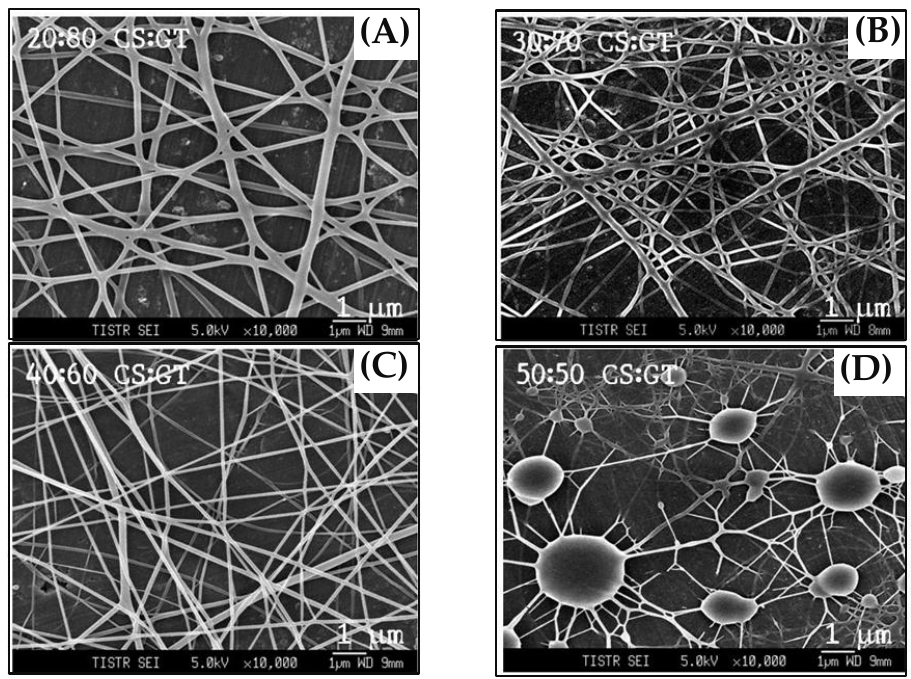
Figure 2. SEM micrographs of nanofibers at different ratios of chitosan and gelatin: ( A ) 20:80; ( B ) 30:70; ( C ) 40:60; and ( D ) 50:50, respectively.